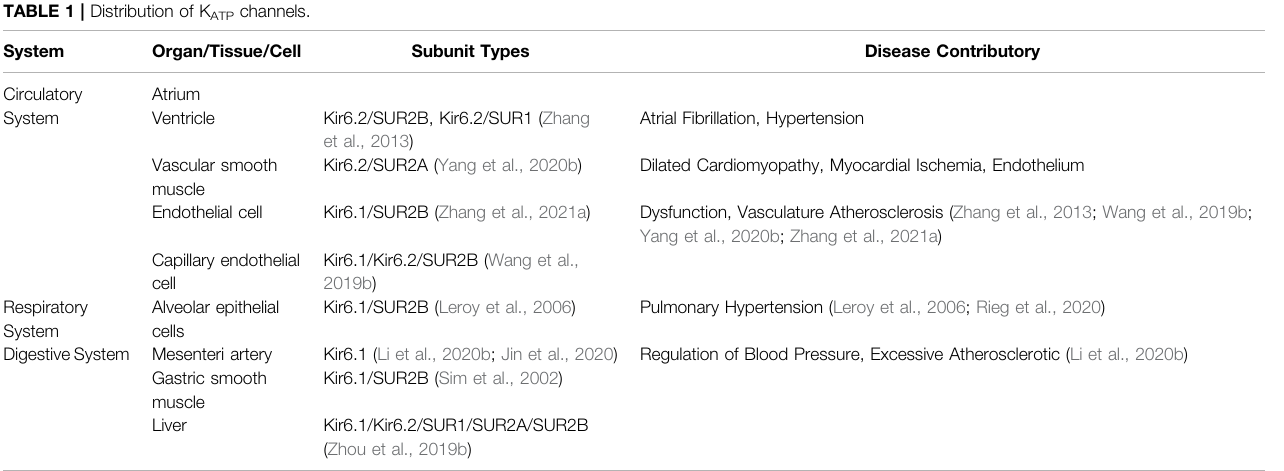
TABLE 1 | Distribution of K ATP